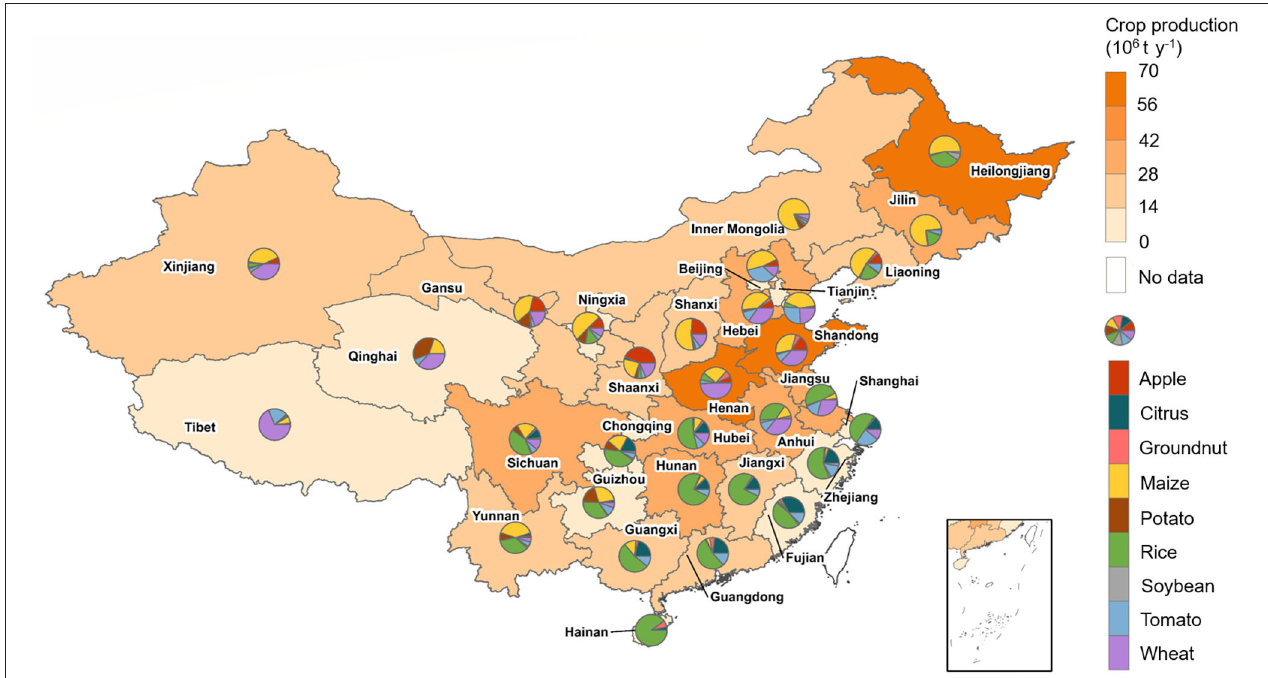
FIGURE 1 | Distribution of total production and production proportion of 9 crops in Chinese mainland provinces